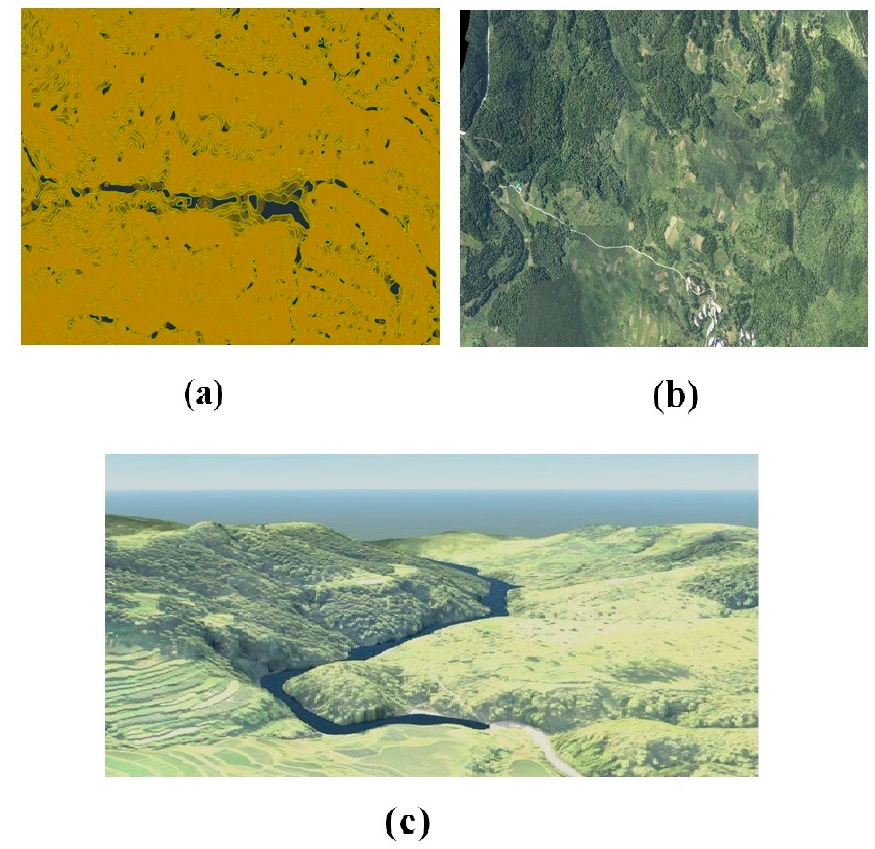
Figure 11. ( a ) 1:2000 geographic map; ( b ) The actual geographic map generated by photogrammetry; and, ( c ) 3D map.